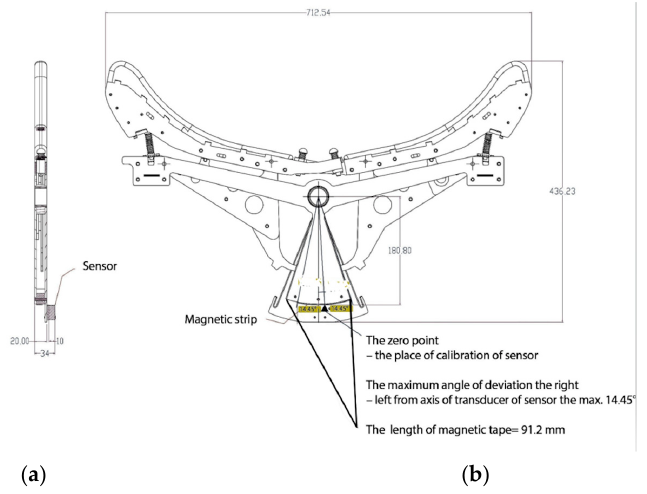
Figure 2. A single support segment, with its sensor and magnetic strip, viewed ( a ) from the side and ( b ) from the front. The base of the dynamic spine correction (DSC) device consists of moveable segments that adjust to and support the spine.